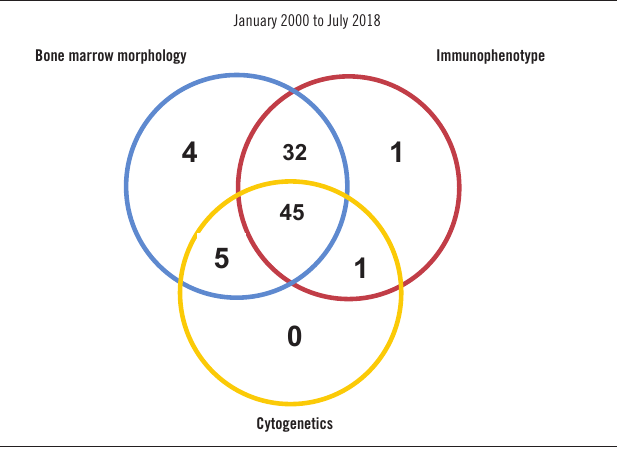
Figure 3: Agreement between methodologies . Set diagrams related to bone marrow morphology, immunophenotype and cytogenetic for patients diagnosed from January 2000 to July 2018.